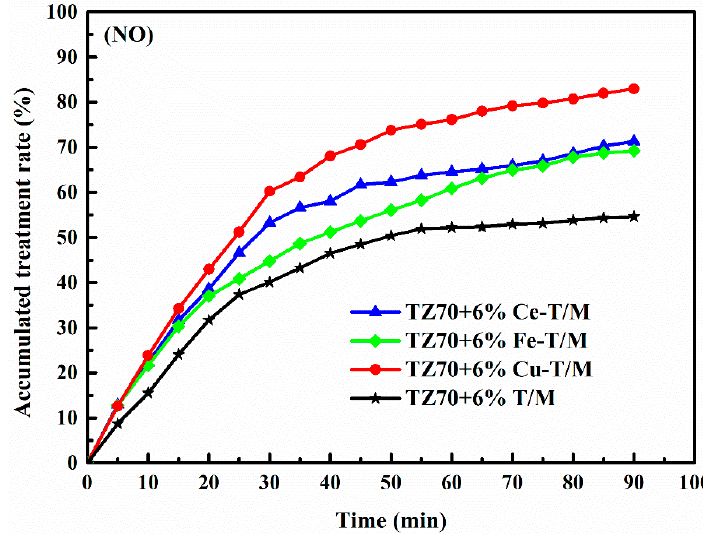
Figure 7. Degradation curve of NO by four modified bitumen.